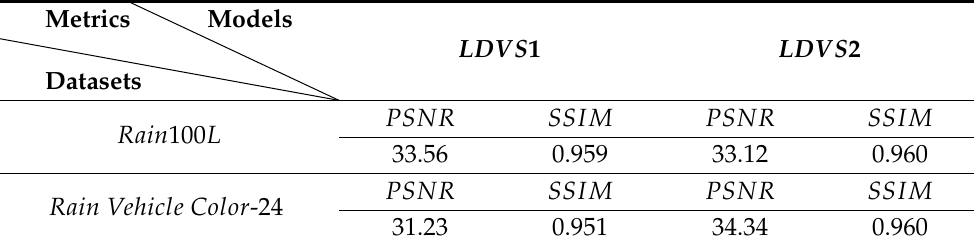
Table 2. Comparing PSNR and SSIM of test effect on Rain Vehicle Color -24 from the LDVS 1 and the LDVS 2.